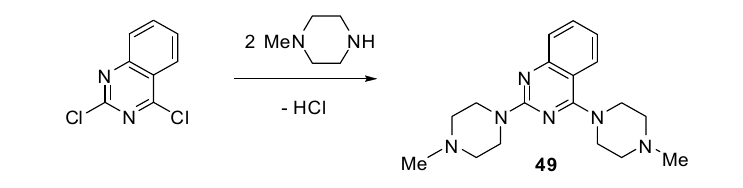
Scheme 3. Synthesis of quinazoline 48 .